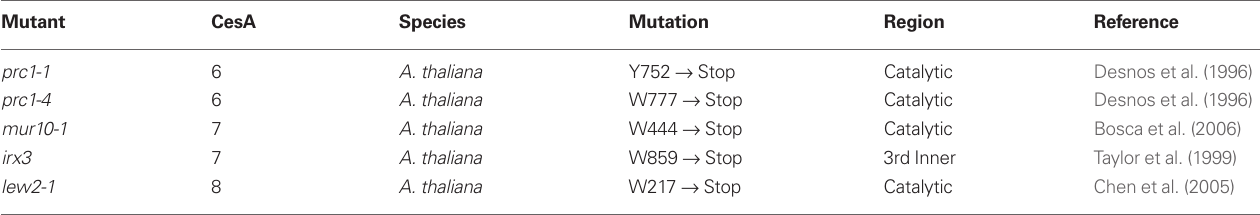
Table 5 | Observed nonsense